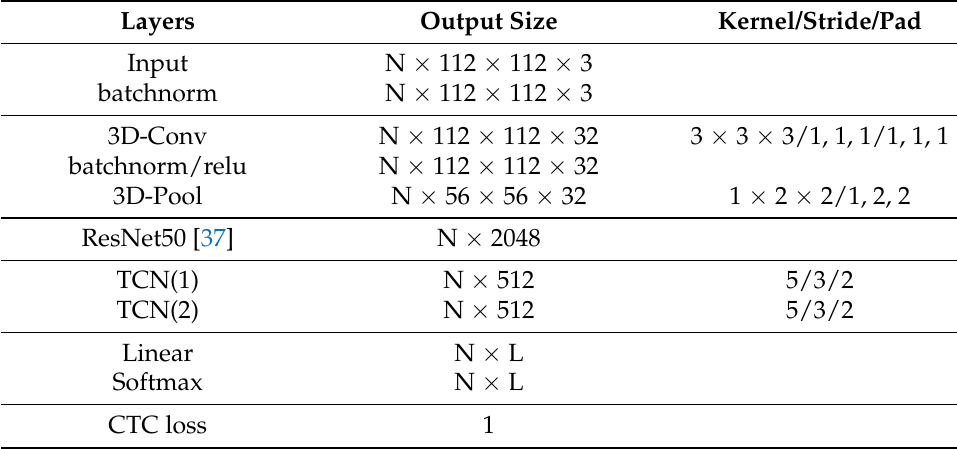
Table 1. The detailed of the proposed lipreading architecture.